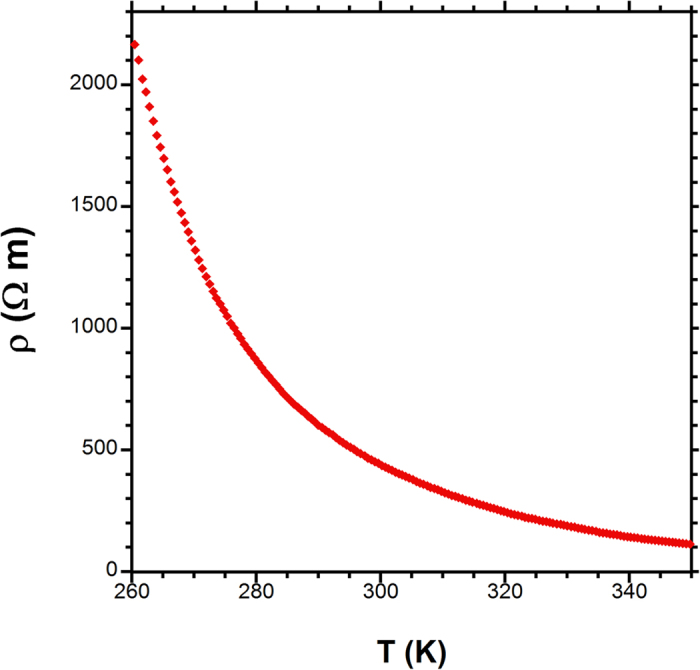
Resistivity vs. temperature for SrLa10Ir4O24.